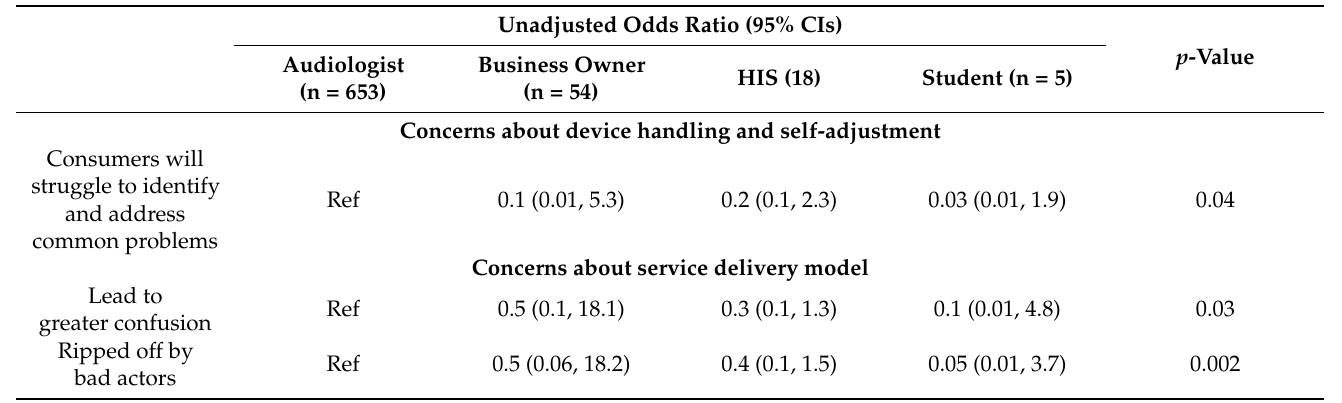
Table 3. Relationship between hearing healthcare professionals’ (HHPs) profession and their views on over-the-counter (OTC) hearing